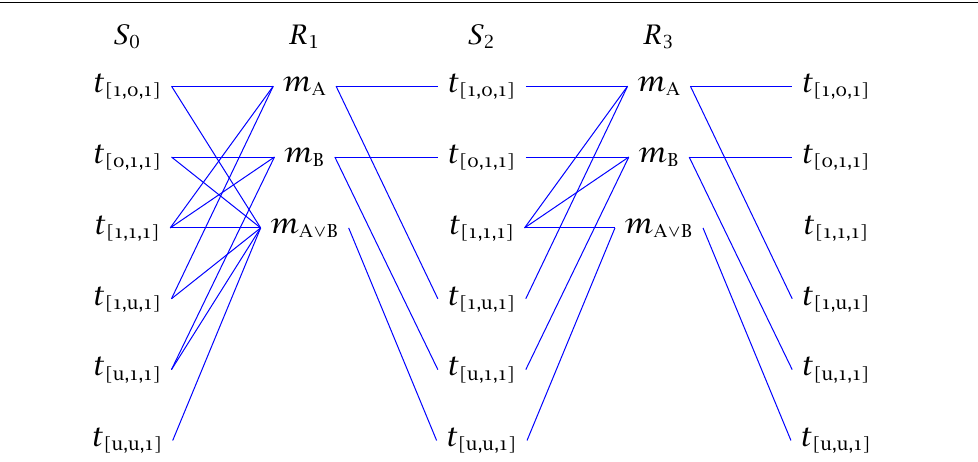
Figure 10 Predictions for epistemic interpretation of “ A or B ” for a = b = c tion, the unique fixed point of ibr reasoning has m t or as t (see Figure 10 ). This captures the reading that the [ 1 , 0 , 1 ] [ 1 , u , 1 ]